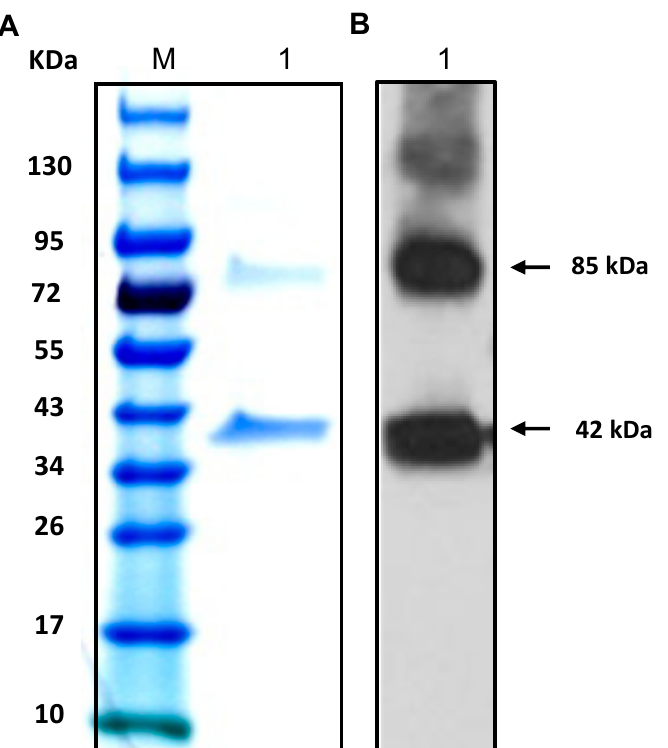
Figure 5. ECH_0379 recombinant protein purified to homogeneity using the pET expression system in E. coli . ( A ) The purified recombinant protein was resolved by 12% SDS-PAGE and stained with Coomassie blue G250 stain. ( B ) Western-blot analysis performed for the SDS-PAGE resolved proteins using the N-terminal expressed His-tag-specific polyclonal sera. (M, protein molecular weight markers; 1, resolved recombinant protein).